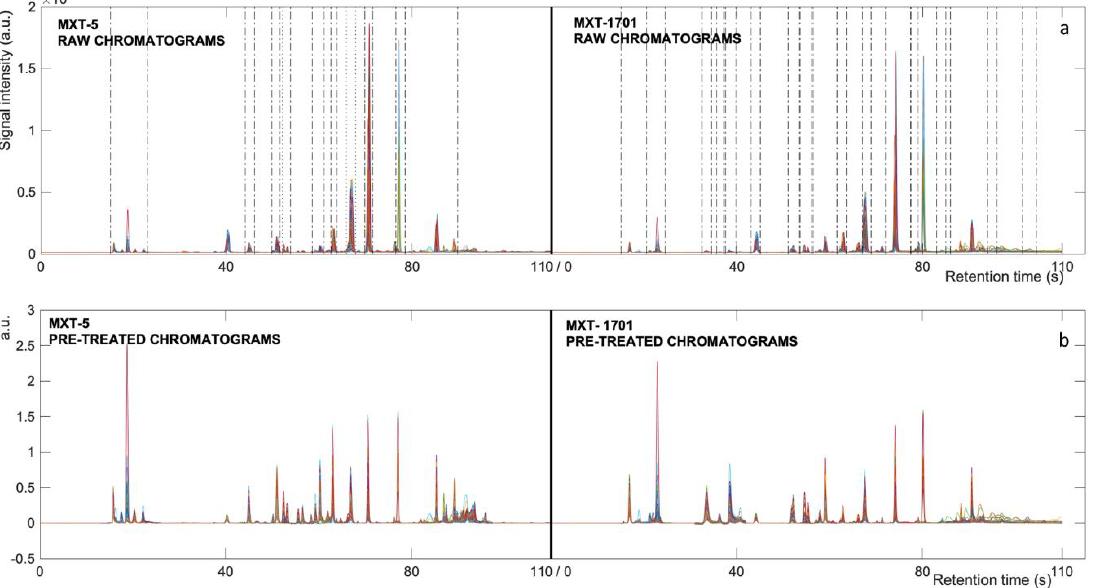
Figure 1. Collected chromatograms of basil samples ( a ) before and ( b ) after the different data pretreatments. ( a ) Dotted lines mark the limits of the different intervals used for the alignment and the scaling of the signals.